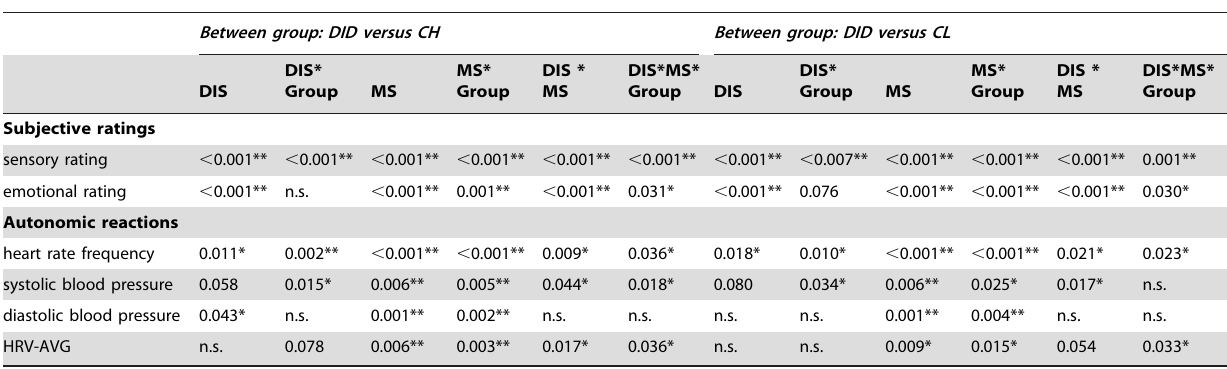
Table 1. Between group: Subjective and autonomic reactions.